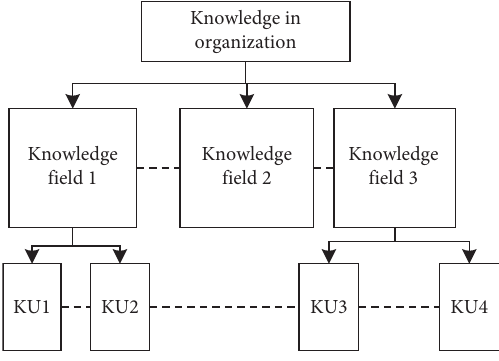
Figure 1: Diagram of a knowledge